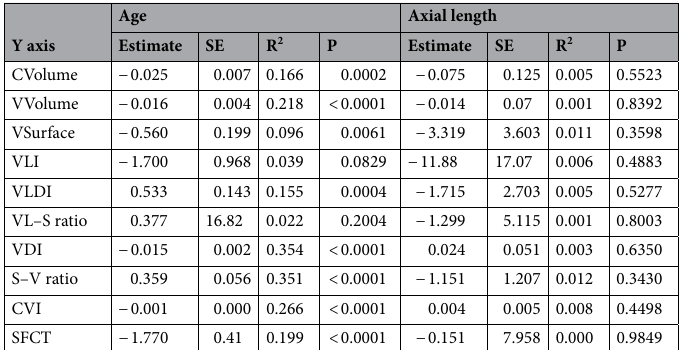
Table 5. Univariate analysis. Each parameter and age, axial length, and measurement. SE standard error.